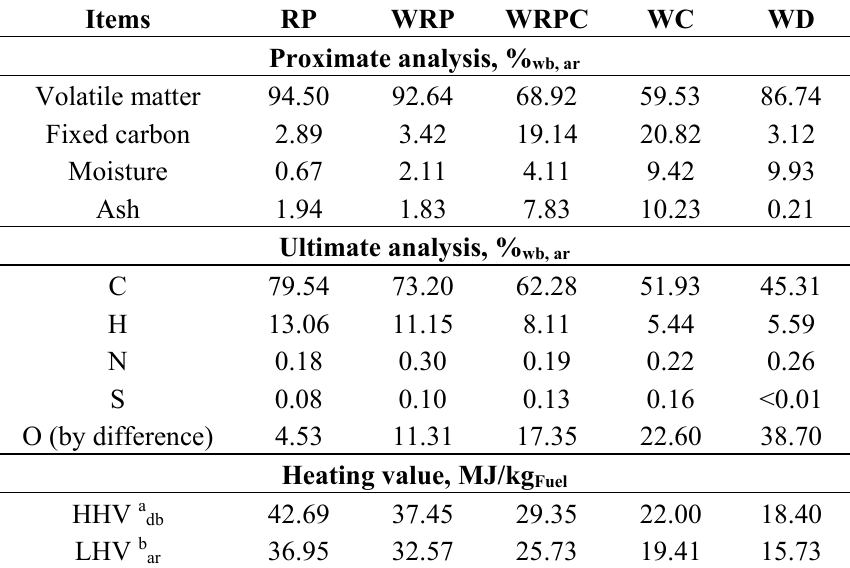
Table 3. Proximate and elemental analyses of the tested